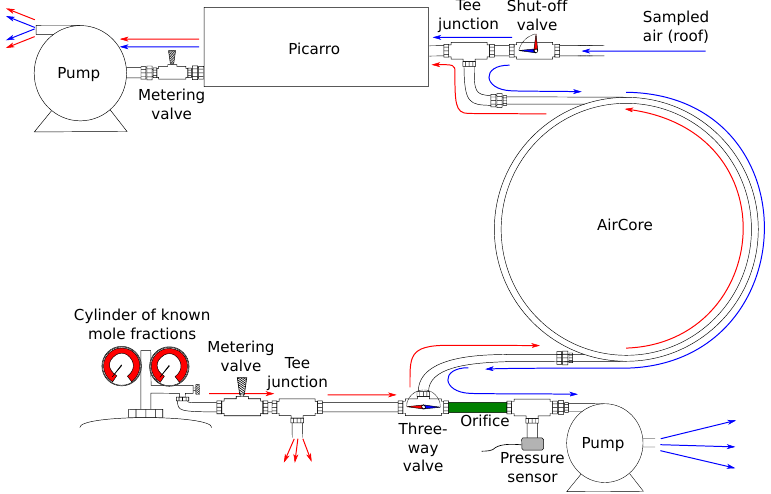
Figure 2. Schematic of the roof air test setup in the laboratory. The blue lines indicate the time at which both the Picarro and the AirCore sample the roof air, while the red lines indicate the time at which the Picarro analyzes the sampled air from the AirCore.